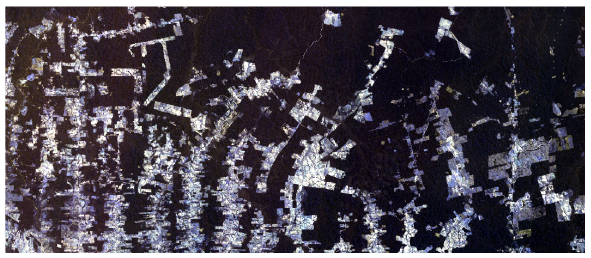
Figure 2. T1: August, 2016.